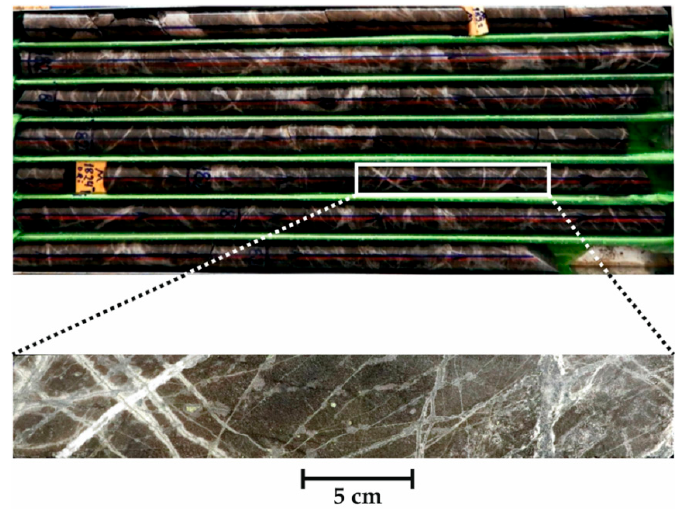
Figure 2. Representative sample selection from homogenous drill-core intervals.